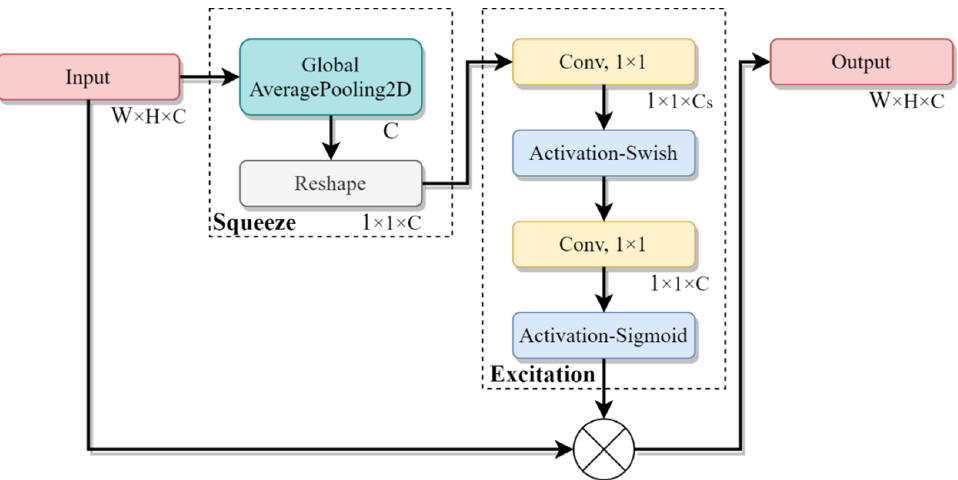
Figure 7. Flowchart of the SENet module.